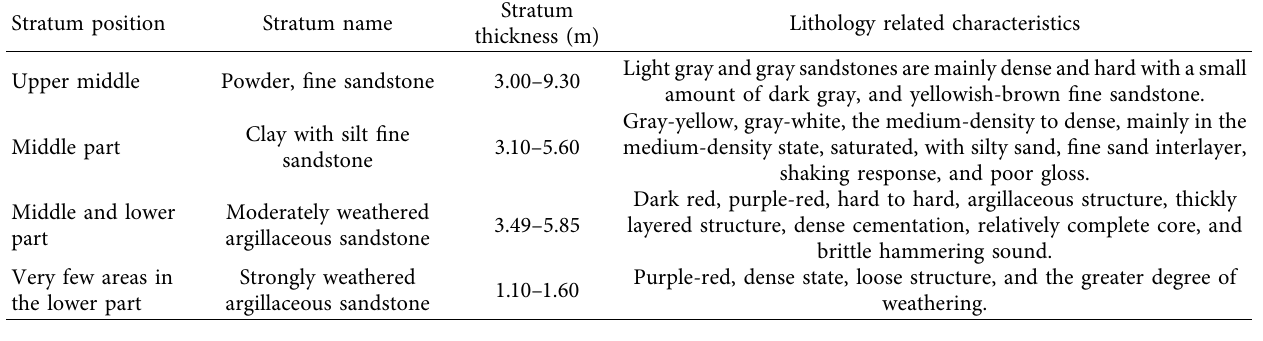
Table 1: 1290 flatbed map.